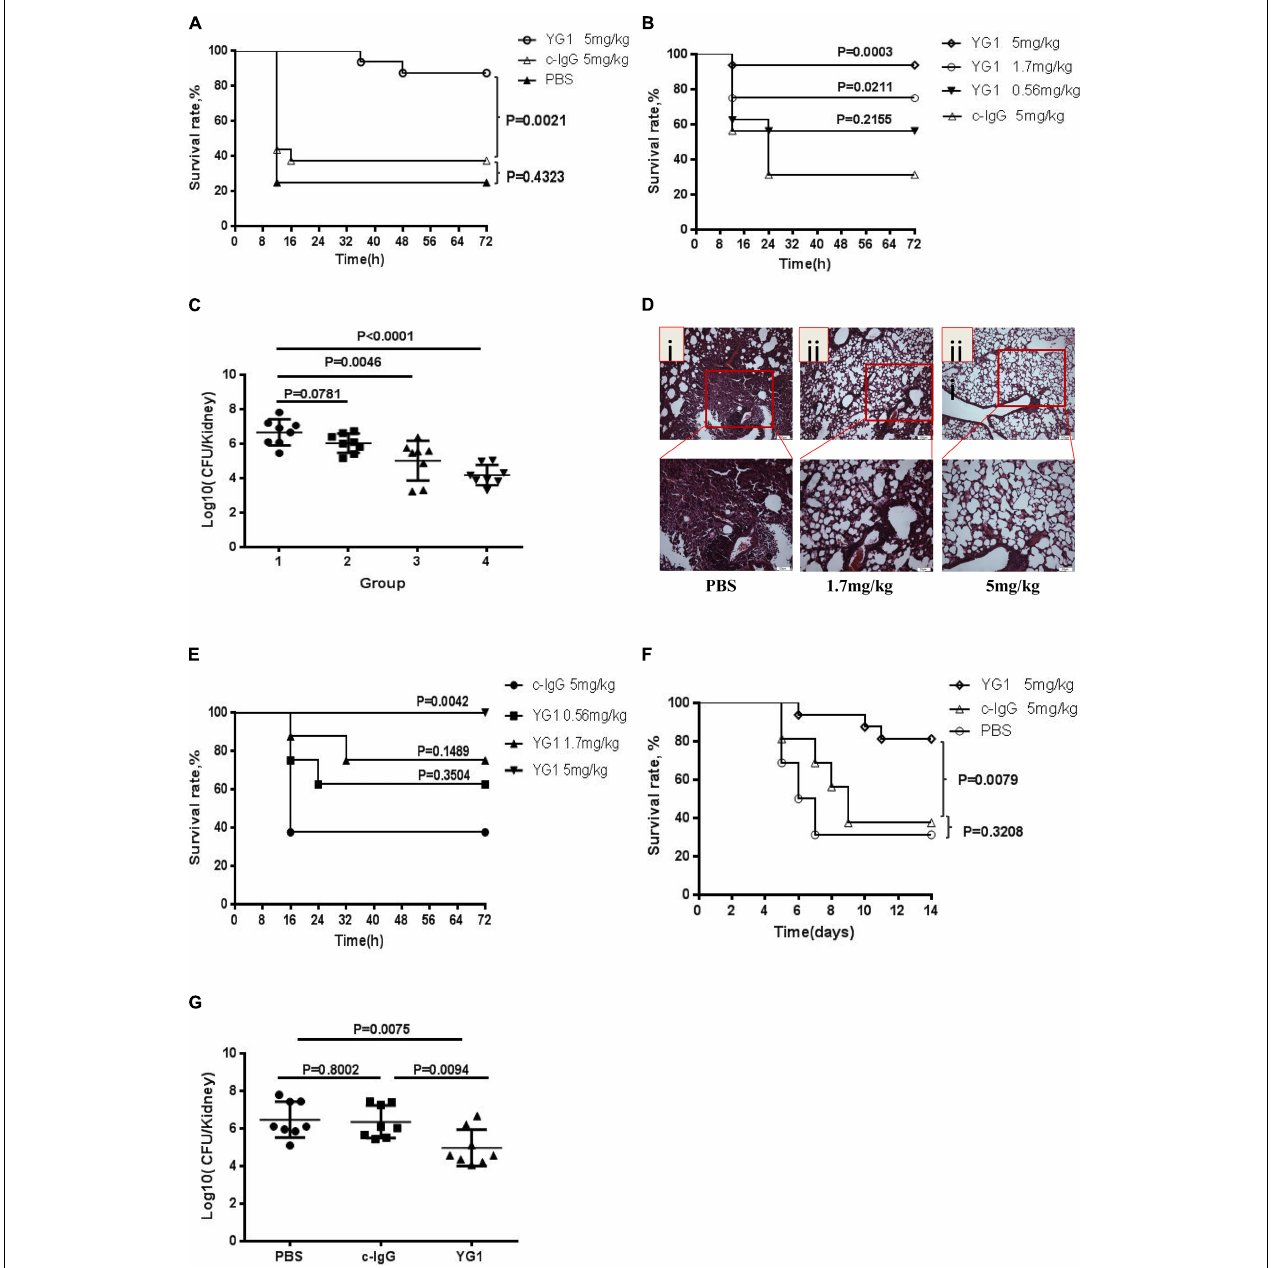
FIGURE 3 | Assessment of the protective effects of YG1 in vivo . (A,B) Assessment of the antimicrobial effects of YG 1 in a murine model of acute peritoneal infection. YG 1 or c-IgG was injected into the peritoneal cavity of BALB/c mice ( n = 16) 4 h prior to challenge with S. aureus 8325-4 (3.8 × 10 8 CFU/mouse) (A) . YG I or c-IgG at the indicated concentrations was injected into the peritoneal cavity of BALB/c mice ( n = 16) 4 h prior to challenge with USA300 (7.5 × 10 8 CFU/mouse) (B) . The survival rates were measured at different time points postchallenge. Data are presented as the percentage of mice surviving. Survival curves were determined using the Kaplan–Meier method and compared using the log-rank test. (C) Bacterial colonies in kidneys were counted at 48 h postinfection [(1) c-IgG 5 mg/kg, (2) YG1 0.56 mg/kg, (3) YG I 1.7 mg/kg, and (4) YG1 5 mg/kg]. Data are representative of three independent experiments and shown as the mean ± SD. (D,E) YG1 protected mice from S. aureus infection in a pneumonia infection model. YG1 was injected into the peritoneal cavity of BALB/c mice ( n = 6) 4 h prior to challenge with S. aureus 8325-4 cells (8 × 107 CFU/mouse). Lung sections were collected at 72 h postchallenge and stained with hematoxylin-eosin (D) . YG1 or c-IgG at the indicated concentrations was injected into the peritoneal cavity of C57BL/6J mice (n = 8) 24 h prior to challenge with S. aureus USA300 (2.3 × 109 CFU/mouse). The survival rates were measured at different time points postchallenge (E) . (F) Determination of the effects of YG I in a bacteremia model. YG I or c-IgG was injected into the peritoneal cavity of BALB/c mice ( n = 16) 4 h prior to intravenous challenge with S. aureus Newman (2.5 × 10 8 CFU/mouse). The survival rates were measured at different time points postchallenge. Data are presented as the percentage of mice surviving. Survival curves were determined using the Kaplan–Meier method and compared using the log-rank test. (G) Bacterial colonies in kidneys were counted at 14 days postinfection. Data are representative of three independent experiments and shown as the mean ± SD. Significant differences between groups were evaluated using two-tailed student’s t tests.